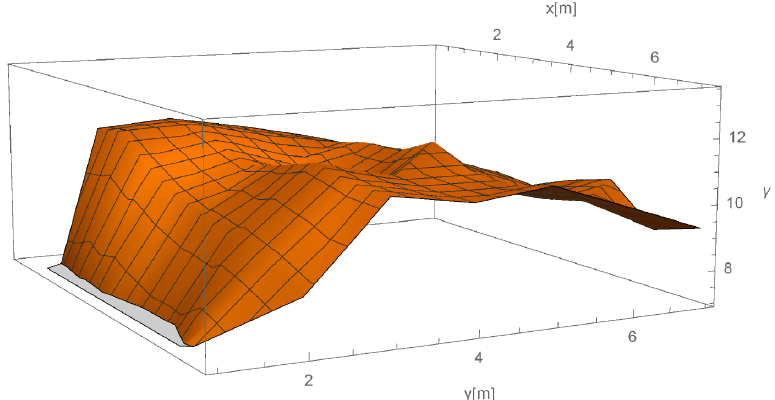
Figure 10. (cid:2011) value calculated for every evaluation point.